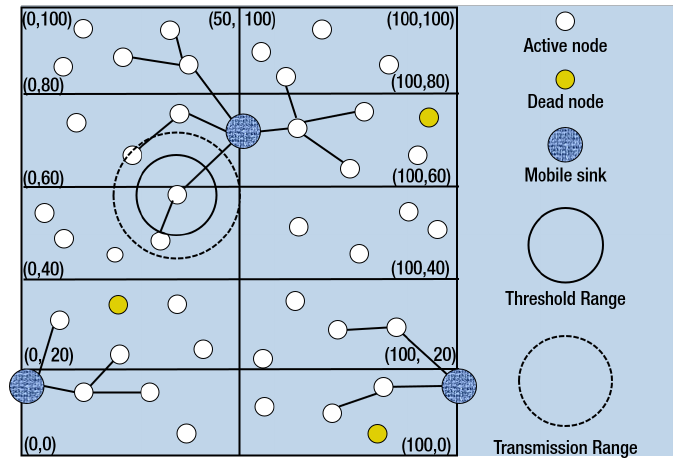
Figure 13. Data transmission in Vertical Sink Mobility (VSM)